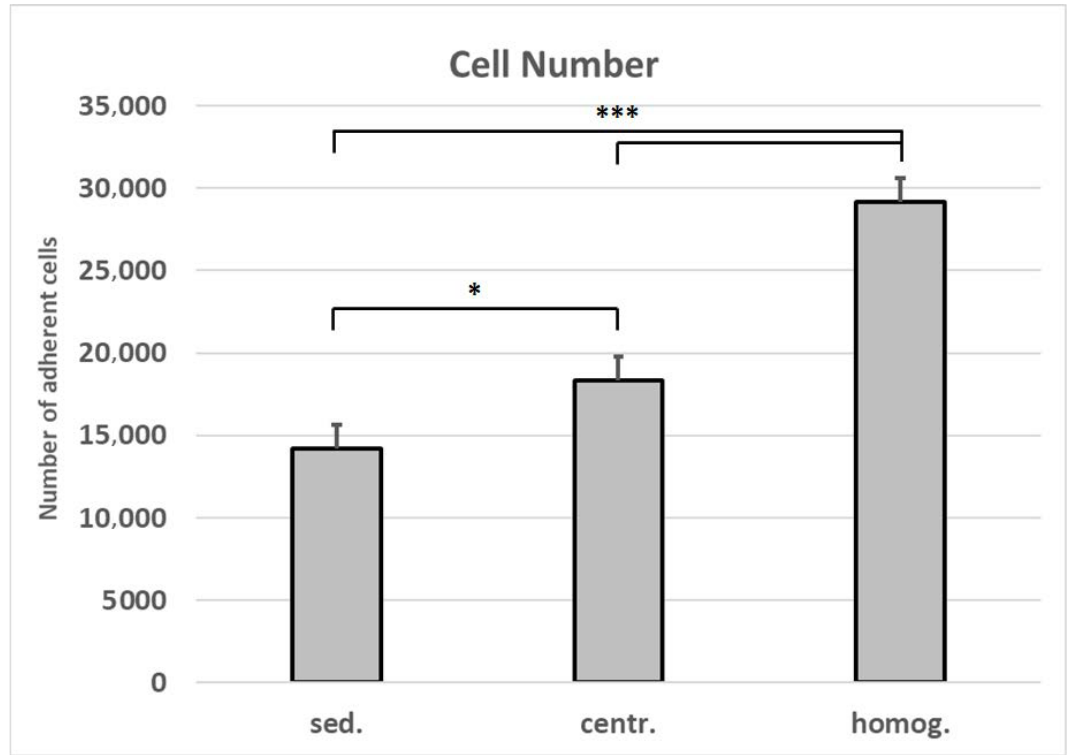
Figure 5. Number of cells isolated from varying tissue processings. Mean values and standard deviations are shown. Student’s test was used to assess statistical significance (* p < 0.05; *** p < 0.001). (sed.: sedimented; centr.: centrifuged; homog.: homogenized).